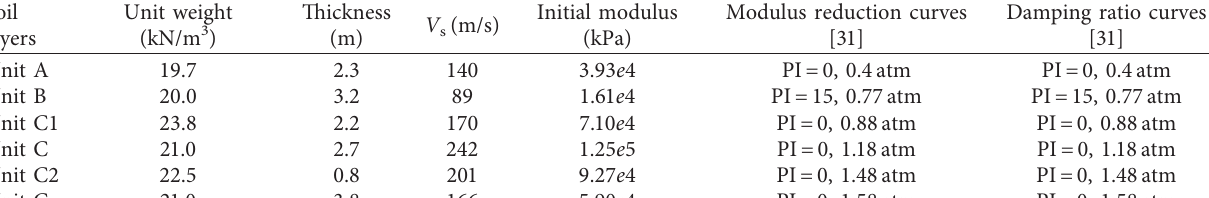
Table 5: Soil parameters used for nonlinear effective analysis.